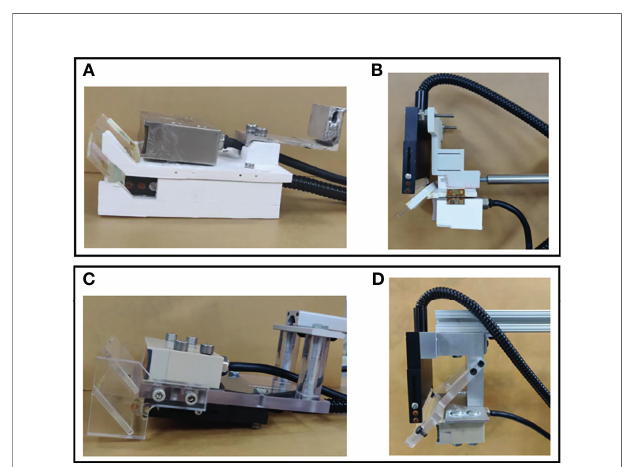
FIGURE 2 | Design of the transducer- fi ber combiner. The fi rst row shows photos from the DSM-1 system, and the second row shows the photos from the DSM-2 system. (A) 3D-printed bottom transducer- fi ber set. (B) 3D- printed top transducer- fi ber set. (C) Precisely machined aluminum-acrylic bottom transducer- fi ber set. (D) Precisely machined aluminum-acrylic top transducer- fi ber